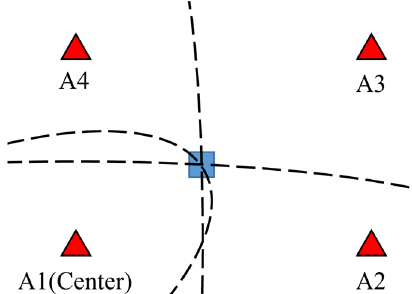
Figure 1. Time difference of arrival (TDOA) hyperbolas. The blue square denotes the tag.